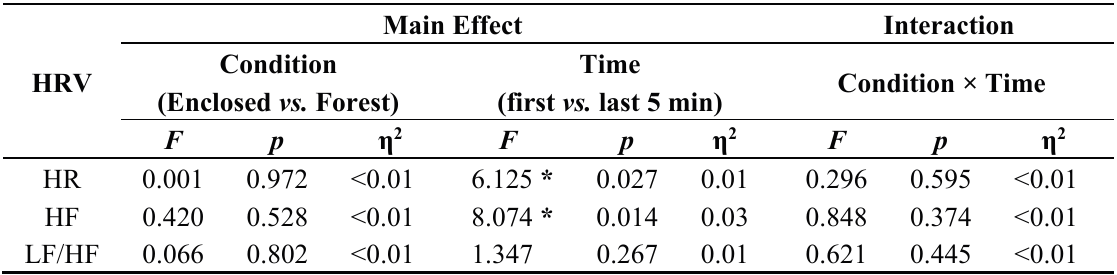
Table 5. Results of the two-way repeated measures ANOVA of heart rate variability